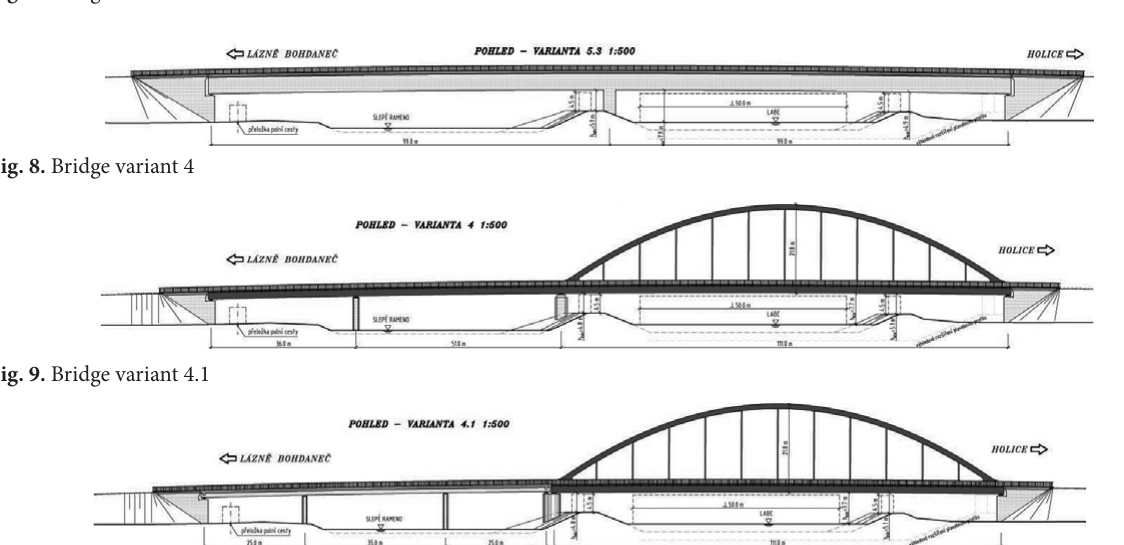
Fig. 7. Bridge variant 3